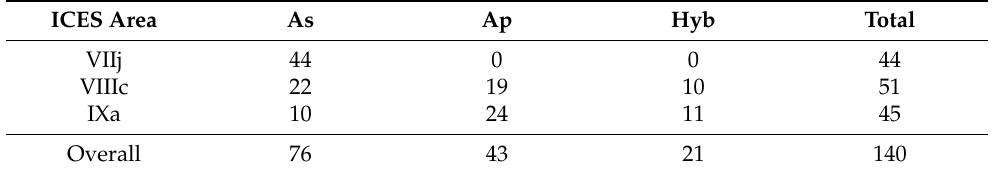
Table 2. Taxonomic identification of Anisakis larvae from viscera analyzed by sequencing of ITS rDNA. ICES